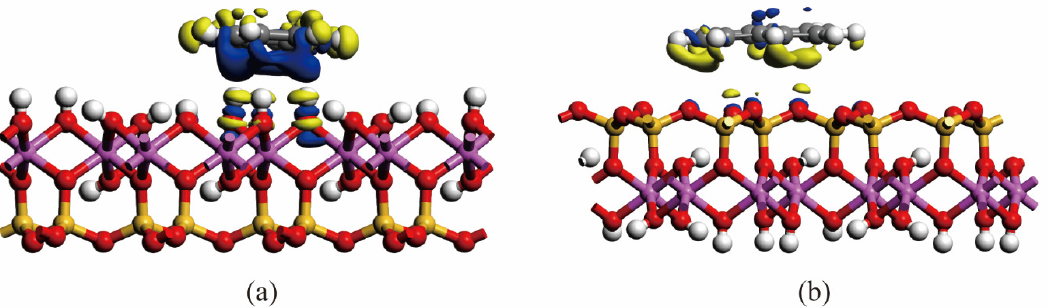
Figure 4. The RFD of potassium atoms (red ball) with naphthalene. The inset figures are ( a ) the initial configuration of naphthalene absorbed on the montmorillonite surface and ( b ) the equilib- rium configuration of naphthalene absorbed on the montmorillonite surface.